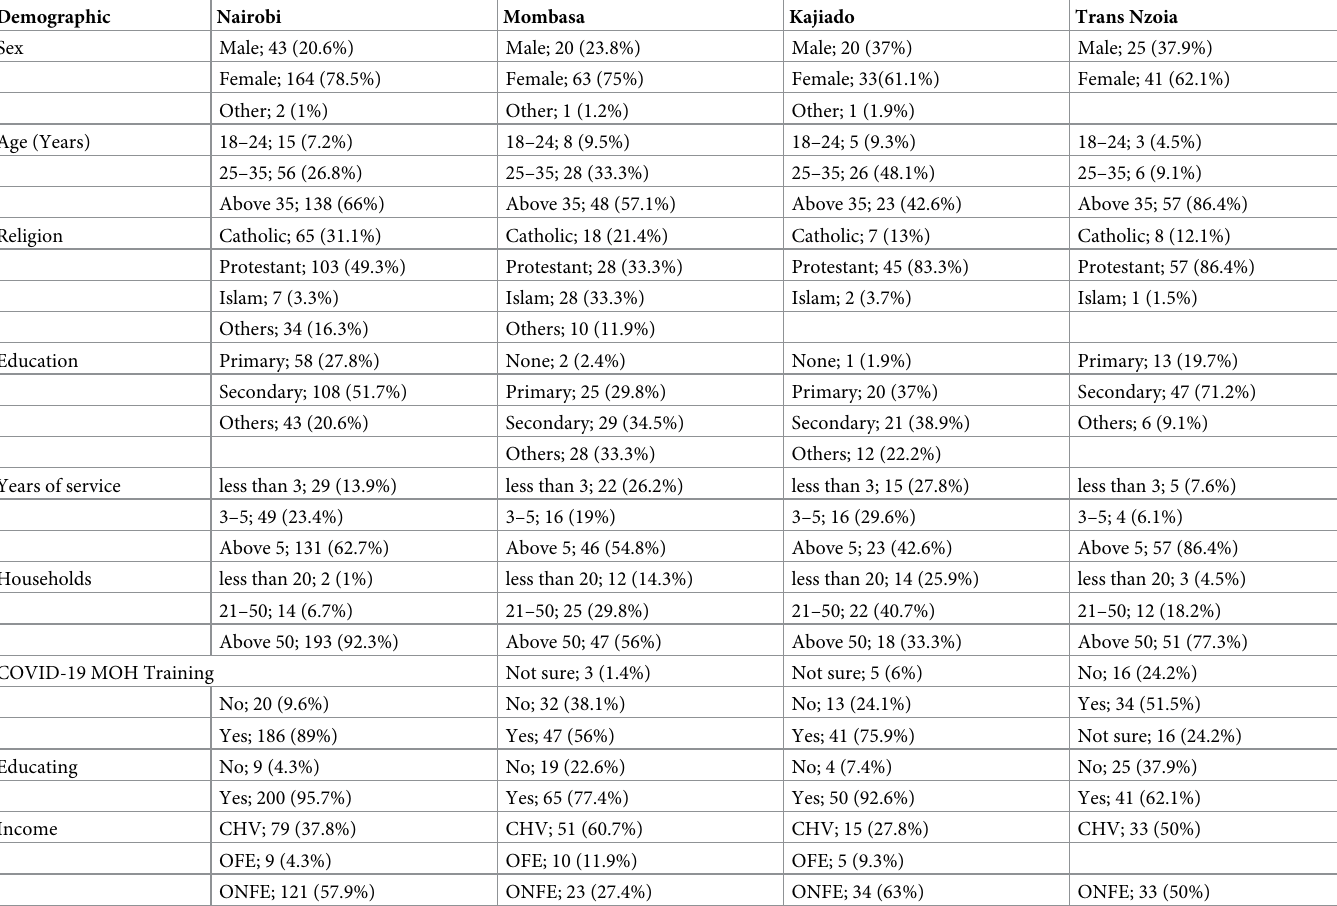
Table 2. Demographic